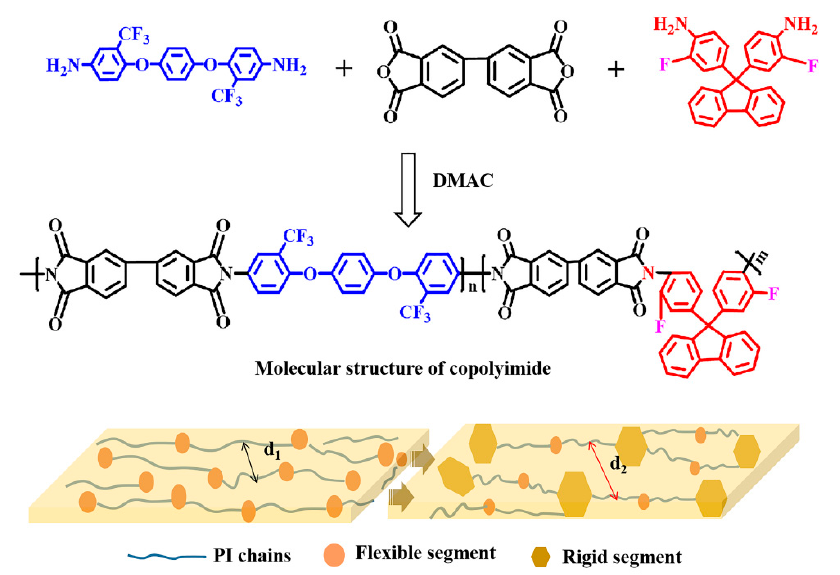
Figure 1. Molecular structure and schematic diagram of the microstructures of the CPI films.